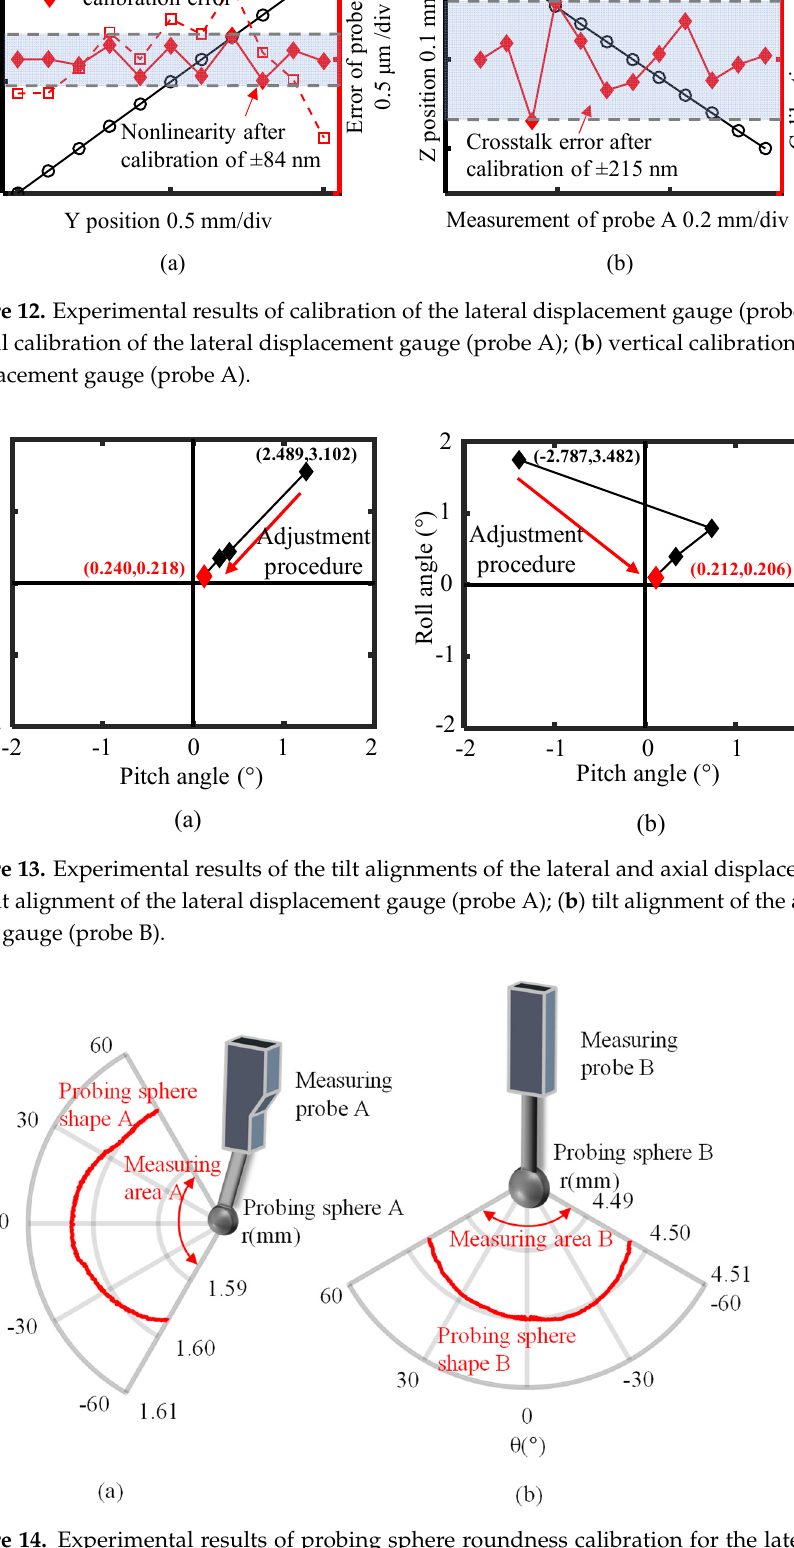
Figure 14. Experimental results of probing sphere roundness calibration for the lateral and axial displacement gauges. ( a ) Sphere roundness calibration of the lateral displacement gauge (probe A); ( b ) sphere roundness calibration of the axial displacement gauge (probe B).